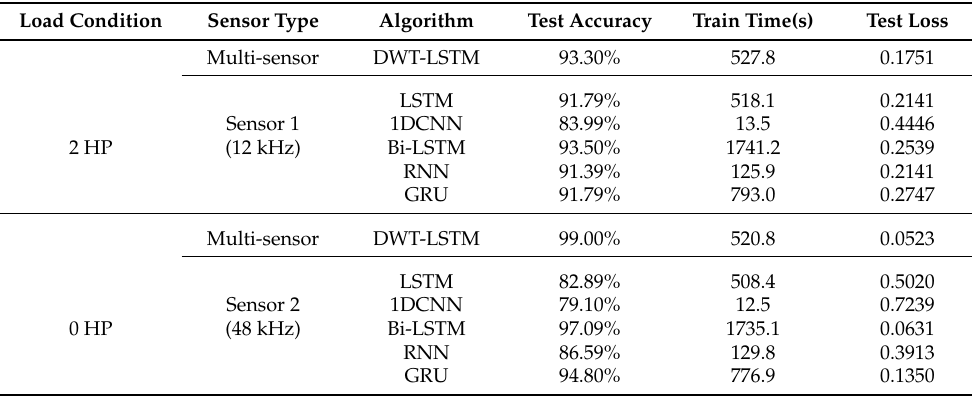
Table 4. Comparison of the accuracy of different